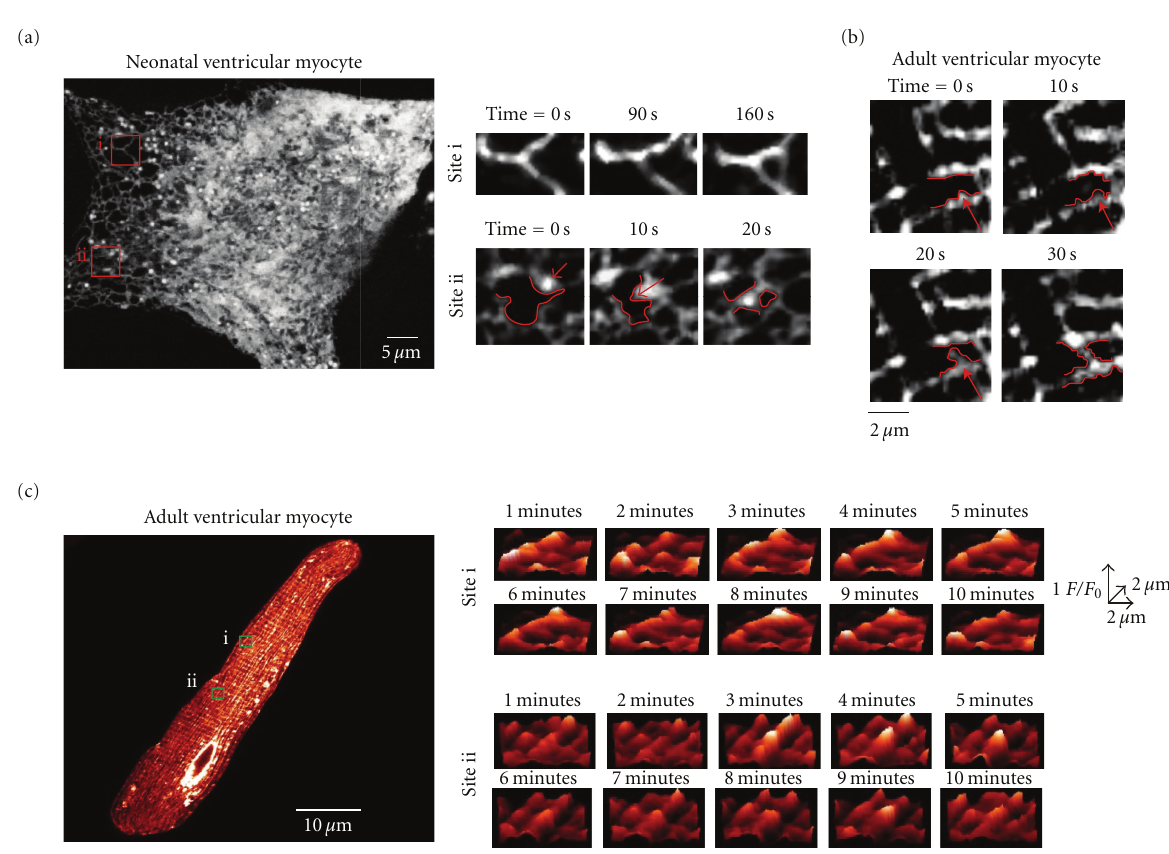
Figure 4: Dynamic remodeling of the SR network of neonatal and adult ventricular myocyte. (a) Confocal image of a neonatal ventricular myocytes expressing tRFP-SR. Images to the left show expanded views of sites i and ii at various time points. The red arrow in site ii marks a corbular SR bouton. Redlines delineate a portion of the SR network and shows elongation and subsequent fusion of this SR bouton to an adjacent SR tubule. (b) Time-lapse confocal imaging of a region of an adult ventricular myocyte expressing tRFP-SR. Redlines delineate a portion of the SR network and shows elongation and subsequent fusion of SR tubule to an adjacent SR tubule. (c) Confocal image of an adult ventricular myocyte. Surface plots at multiple time points of sites i and ii are shown to the right of this